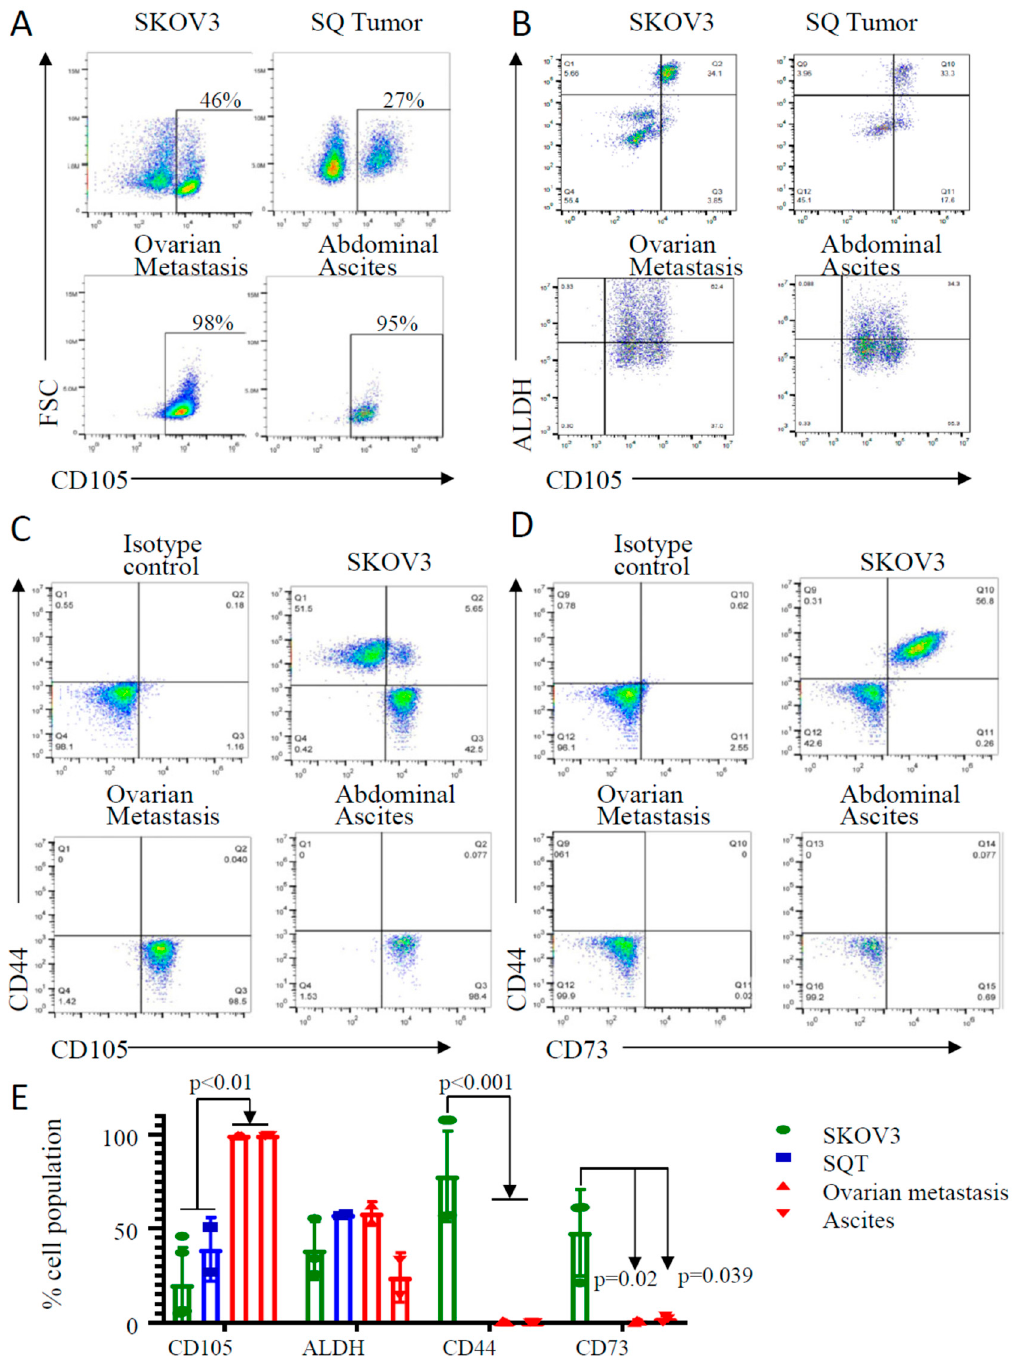
Figure 3. Cell surface marker and cancer stem cell marker expression in ovarian and abdominal metastases. ( A–D ) Flow cytometric analysis of bulk SKOV3 cells in culture, tumor cells derived from subcutaneously injected SKOV3 (SQ) and ovarian metastasis and abdominal metastasis from IV-injected SKOV3 for the indicated cell markers. Results are representative analyses from two to three independent experiments. ( E ) Summary of CD105 and other stem cell markers expression in SQ tumor, ovarian metastasis, abdominal metastasis, and bulk SKOV3 ovarian cancer cell line as described in (A–D).